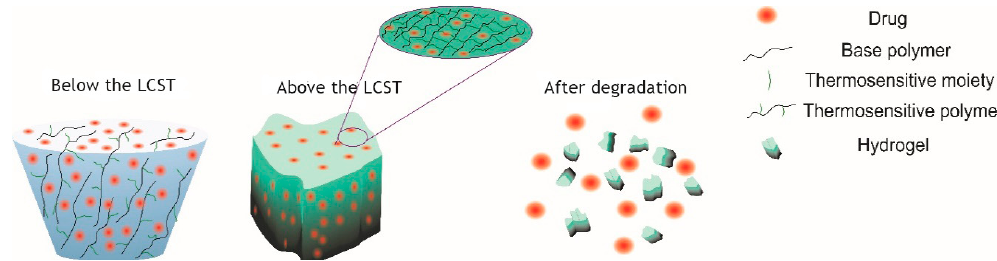
Figure 1. Schematic degradation of thermosensitive hydrogel below and above LCST.